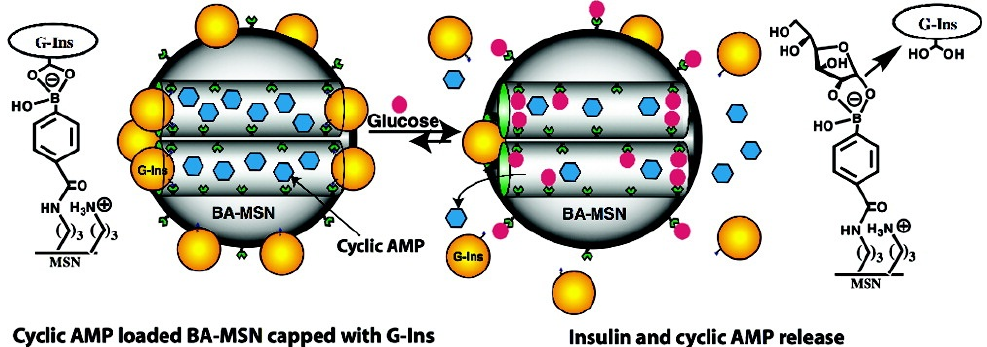
Figure 6. Schematic representation of the glucose-responsive MSN-based delivery system for controlled release of bioactive G-Ins and cAMP. Reproduced with permission from [79]. Copyright American Chemical Society,